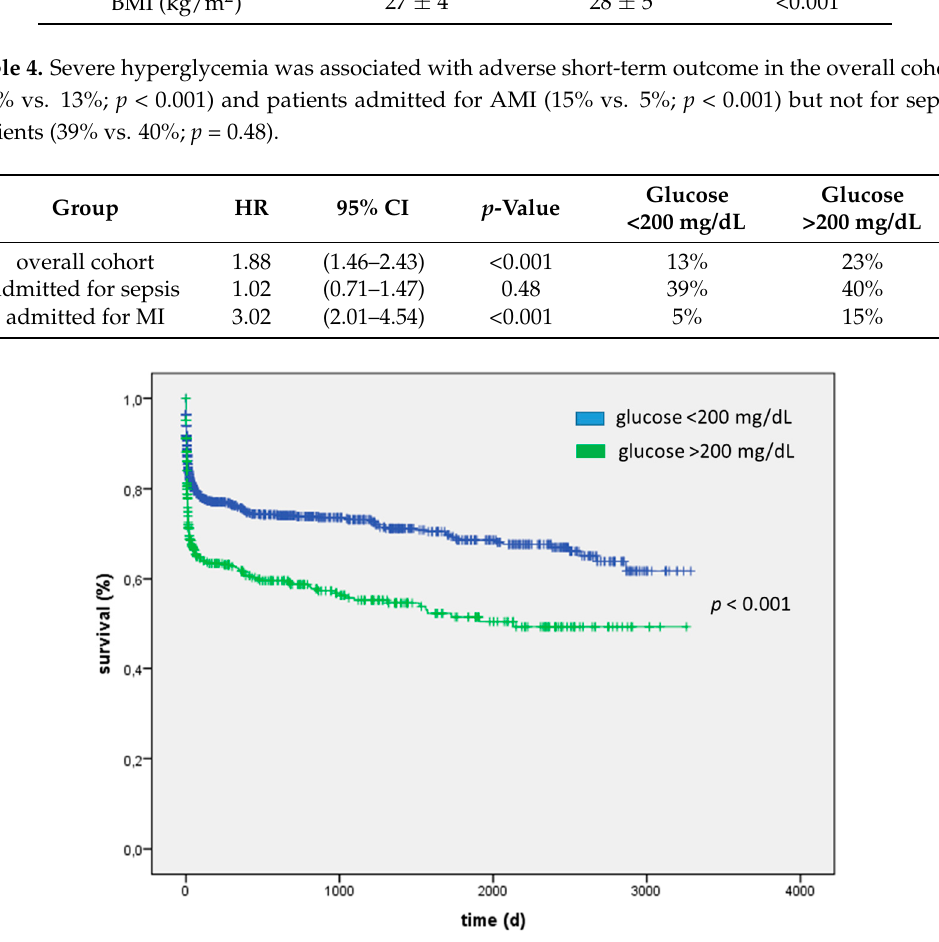
Figure 1. In the overall population severe hyperglycemia (>200 mg/dL) was associated with increased mortality in the long-term (HR 1.74, 95% CI: 1.44–2.09; p < 0.001). For patients admitted for sepsis, severe hyperglycemia was not associated with increased mortality, neither short-term (40% vs. 39%; p = 0.5) nor long-term (HR = 1.13, 95% CI: 0.89–1.44; p =